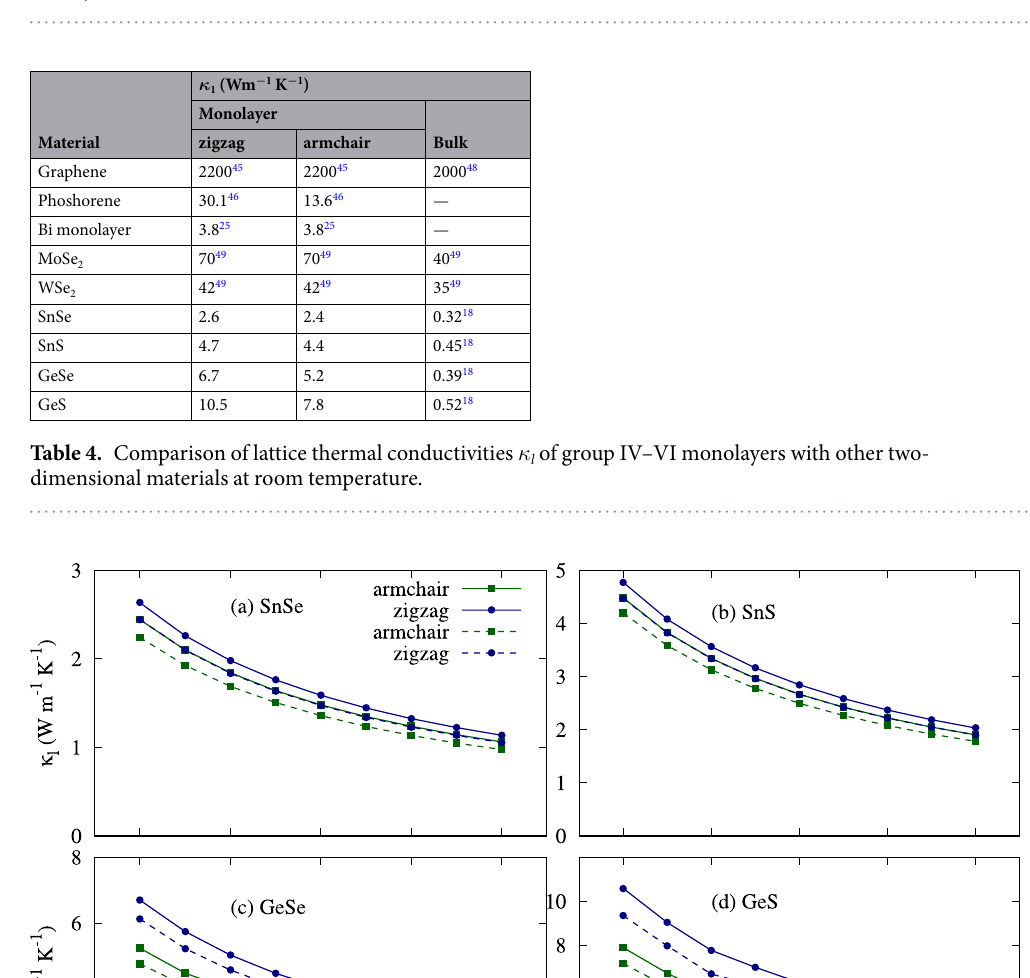
Table 3. The largest values of Seebeck coefficients ( S ) of bulk and monolayer SnSe, SnS, GeSe, and GeS at 300 K (unit: μ VK − 1 ). 1 Ref. 18.